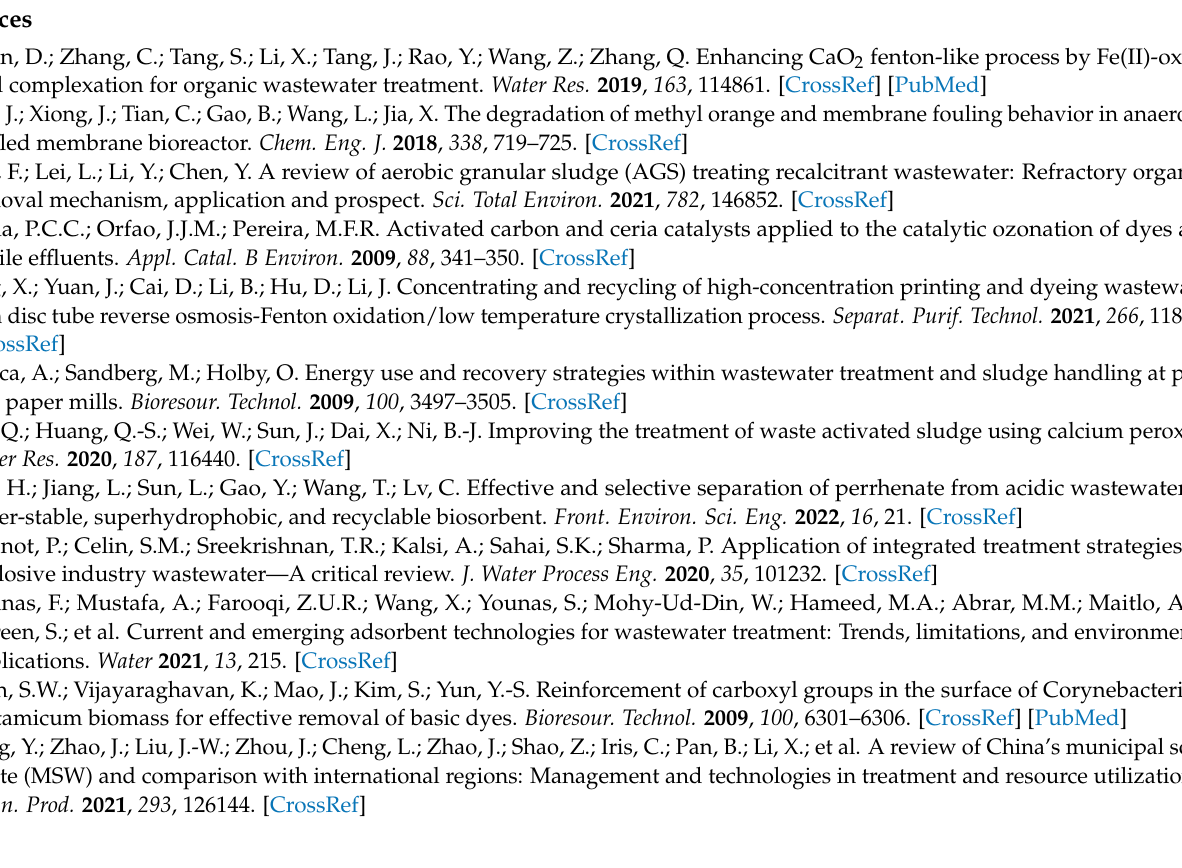
S5: The degradation effect of the Rh B with time increased. Figure S6: The Concentration of COD before and after degradation. Figure S7: The degradation effect of Rb B and MO at different pH and different strong acid. Figure S8: The effect of add HCl and H 2 SO 4 on the degradation of Mo and Rh B. Table S1: The main components of bentonite; Table S2: The specific surface area of different materials; Table S3: The Michaelis-Menten constant ( K m ) and maximum reaction rate ( V max ) of the as-obtained CeAY with TMB as the substrate; Table S4: Degradation intermediates of RhB in the CeAY system; Table S5: Degradation intermediates of RhB in the CeAY